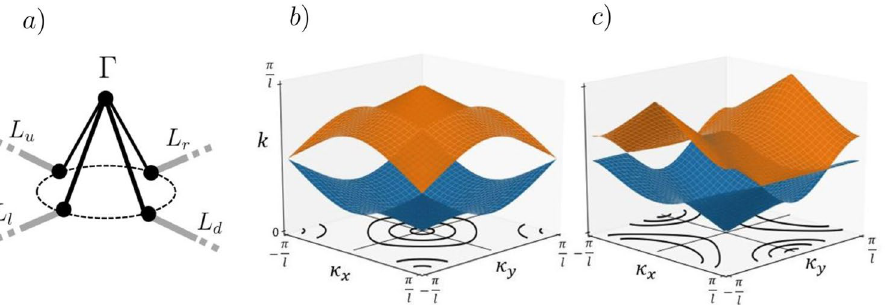
Figure 7. ( a ) Shows the cross resonator plugged into the metamaterials unit cell with scattering matrix defined ( k l x , l y ) in (25). Both ( b ) and ( c ) show the resulting band for different values of l x and l y . Also plotted in as ˆ S Ŵ cross ; the κ x , κ y plane are the iso-frequency contours of the second band for various values of k . Plot ( b ) is for l x 0 , l 1 . Plot ( c ) is for l 1 l y x = y = =